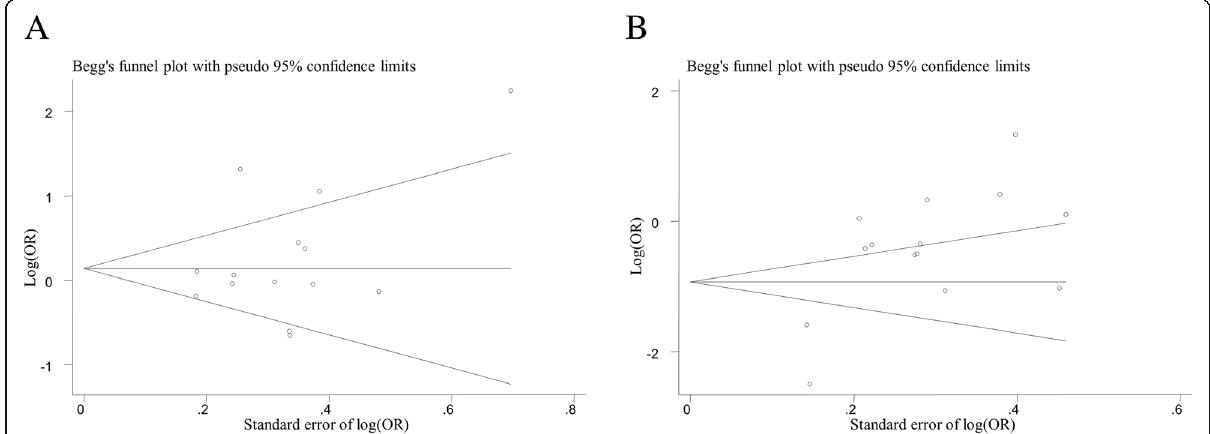
Fig. 2 Funnel plot for meta-analysis of the association of APOE E4 with GSD risk. a Funnel plot for meta-analysis if APOE E4 (yes vs. no); b ) Funnel plot for meta-analysis of APOE E4 assuming an additive model. The x-axis is the standard error of the log-transformed odds ratio (log [OR]), and the y-axis is the log-transformed odds ratio. The horizontal line in the figure represents the overall estimated log-transformed odds ratio. The two diagonal lines represent the pseudo 95% confidence limits of the effect estimate. GSD, gallstone disease; OR, odds